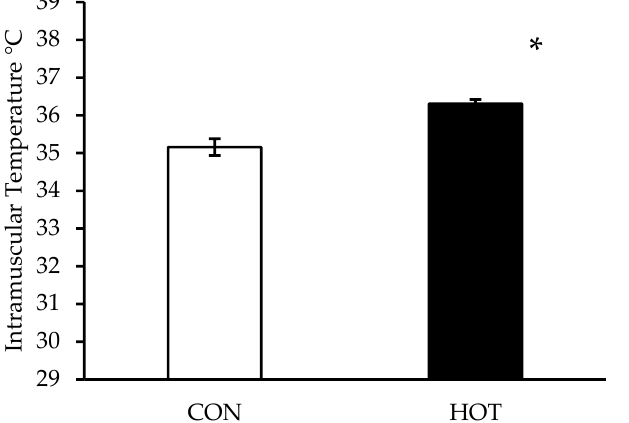
Figure 1. Intramuscular Temperature after 4 h in the control (CON) and heated (HOT) limbs. Data are means ± SD; * p < 0.05 from CON.